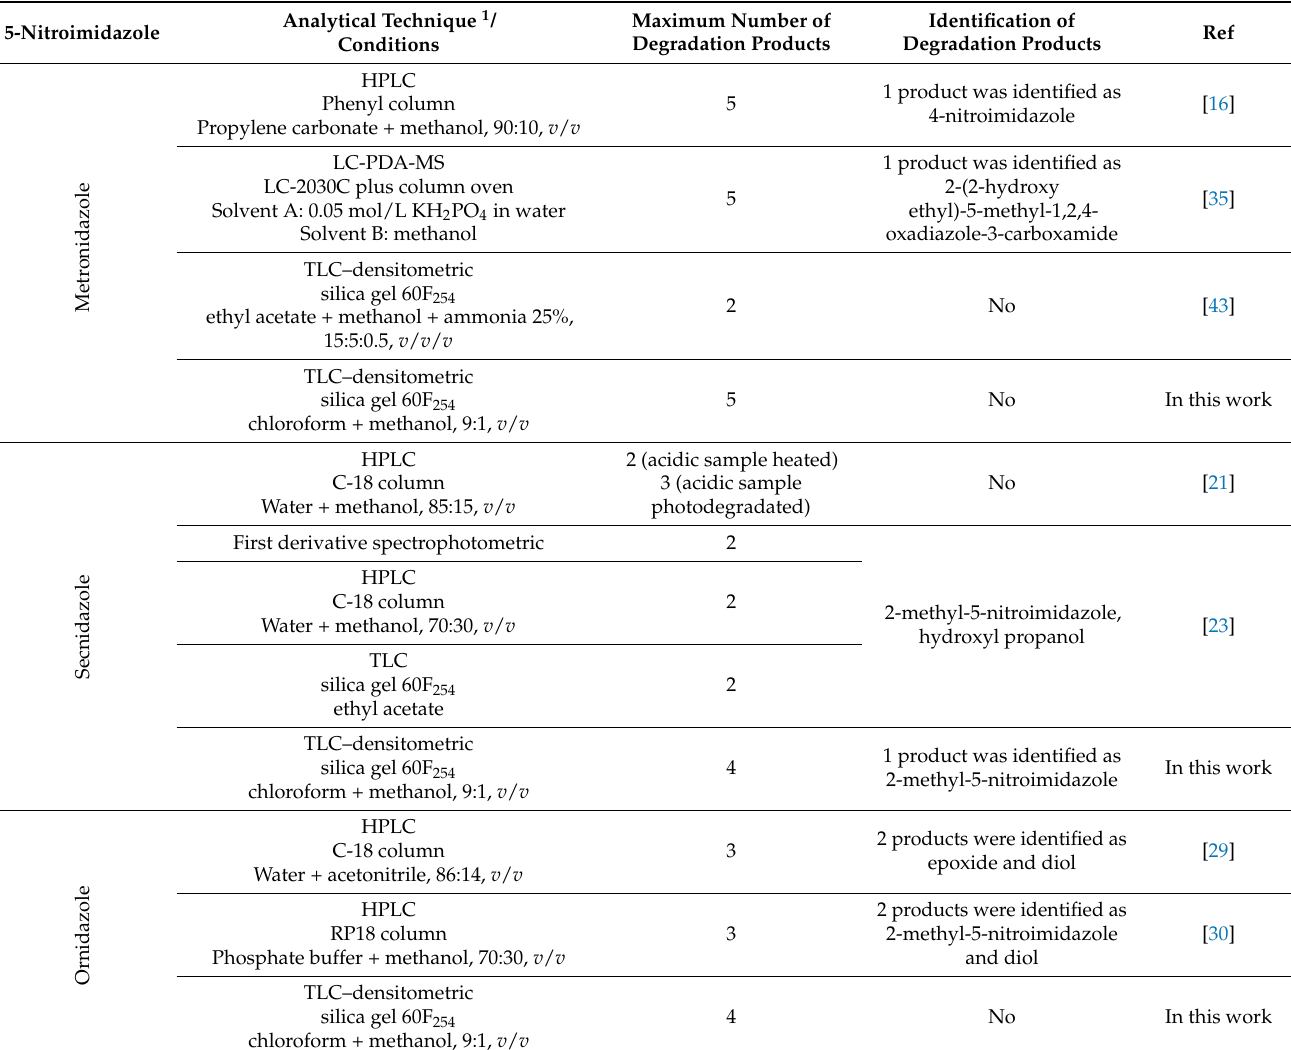
Table 2. Maximum number of degradation products of metronidazole, secnidazole, ornidazole, and tinidazole detected by various analytical